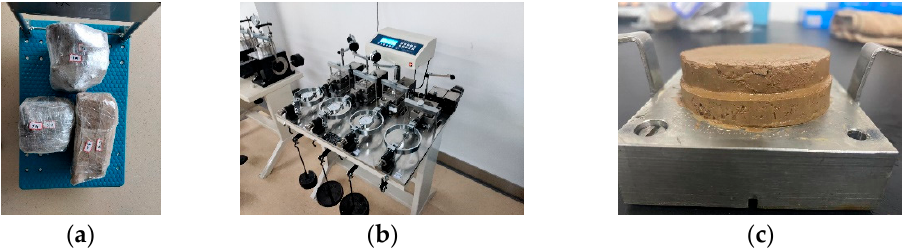
Figure 2. Direct shear tests of standard samples of undisturbed collapsible loess. ( a ) Soil samples. ( b ) Direct shear gauges. ( c ) Soil specimen after direct shear test.